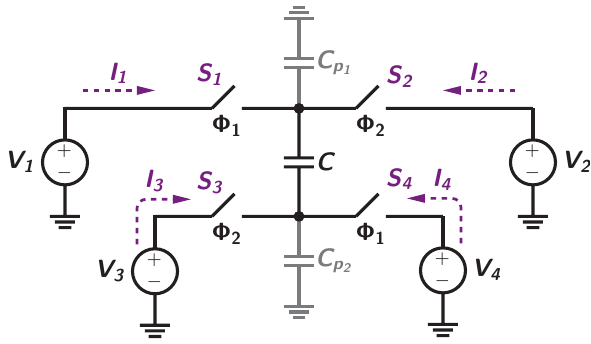
Figure 8. Single-stage DCP, including parasitic